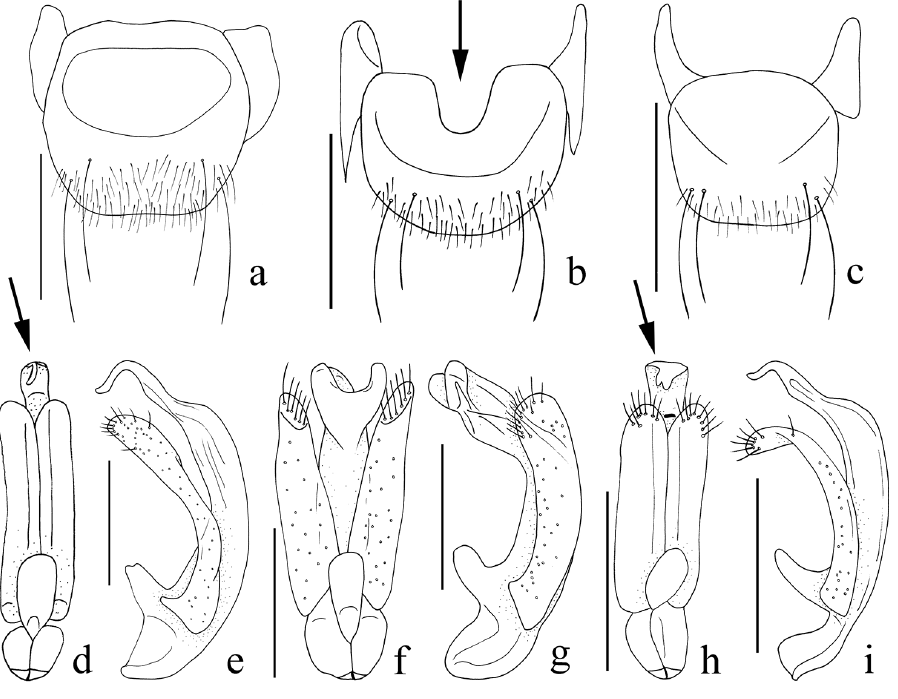
Figure 4. Female abdominal sternites IX, ventral view. a Nornalup afoveatus sp. n. b N. quadratus sp. n. c N. minusculus sp. n. Aedeagi of N. afoveatus sp. n. d dorsal view e lateral view. Aedeagi of N. quadratus sp. n. f dorsal view g lateral view. Aedeagi of N. minusculus sp. n. h dorsal view i lateral view. Scale bars: 0.1